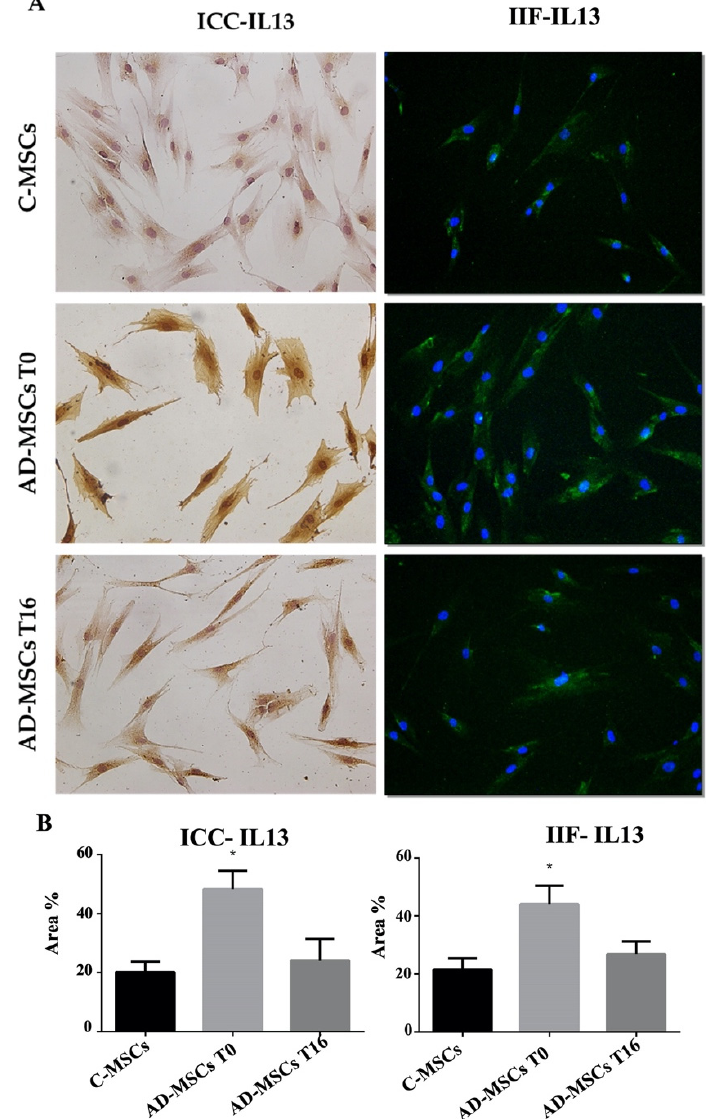
Figure 2. Analysis of the expression of IL13 by Immuno-cytochemistry (ICC), and indirect immune- fluorescence (IIF). ( A ) Representative images of IIF and ICC of IL13 on MSCs from healthy controls (C-MSCs), and MSCs from patients with AD (AD-MSCs) at T0 and at T16. For IIF, a secondary FITC-conjugated antibody was used after incubation with the primary antibodies. Nuclei were counterstained with Hoechst 33342. For ICC, slides were treated with 3,3-diaminobenzidine and counterstained with Mayer’s hematoxylin. (Scale bar: 100 µ m). ( B ) Quantification of proteins expression processed by Fiji-ImageJ. Protein expression is represented by the percentage of the area it occupies inside the cell. The * indicates significative differences of C-MSCs vs. AD-MSC (unpaired t -test; p <